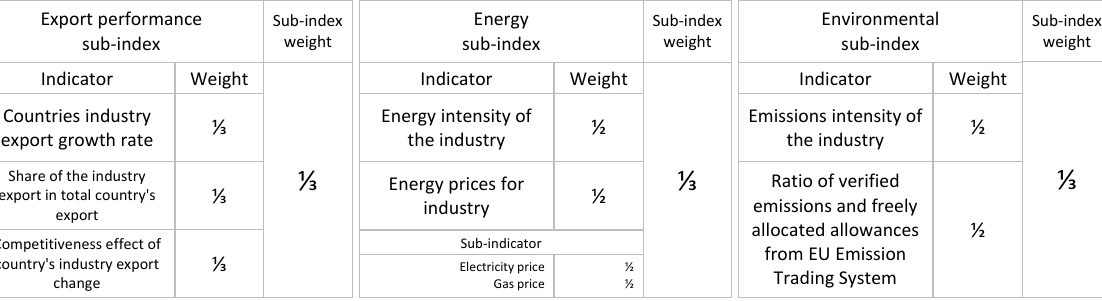
Figure 1. Industry competitiveness index of energy efficiency and carbon emission.